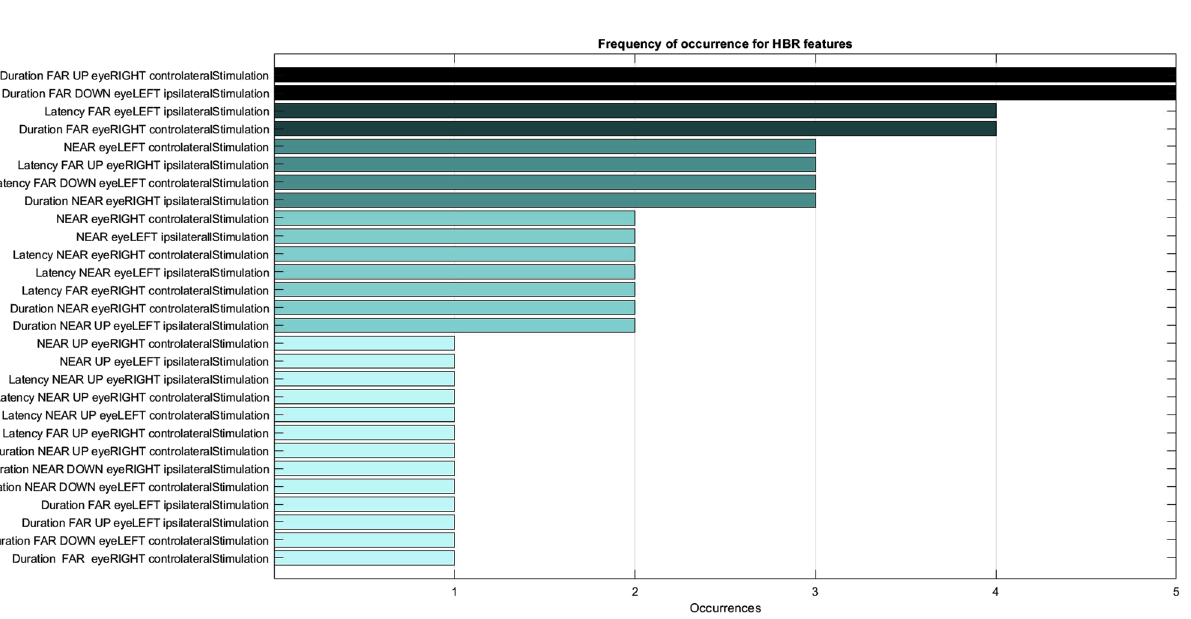
Figure 2. Frequency of occurrence of the HBR features over the five model development folds. Features which are always assigned an importance of 0 are not